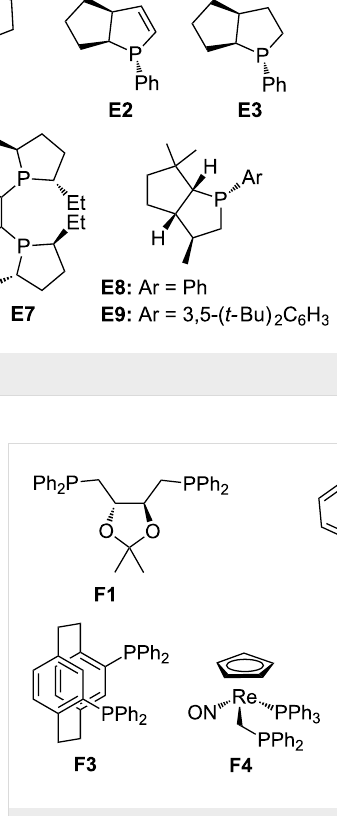
Figure 6: Acyclic chiral